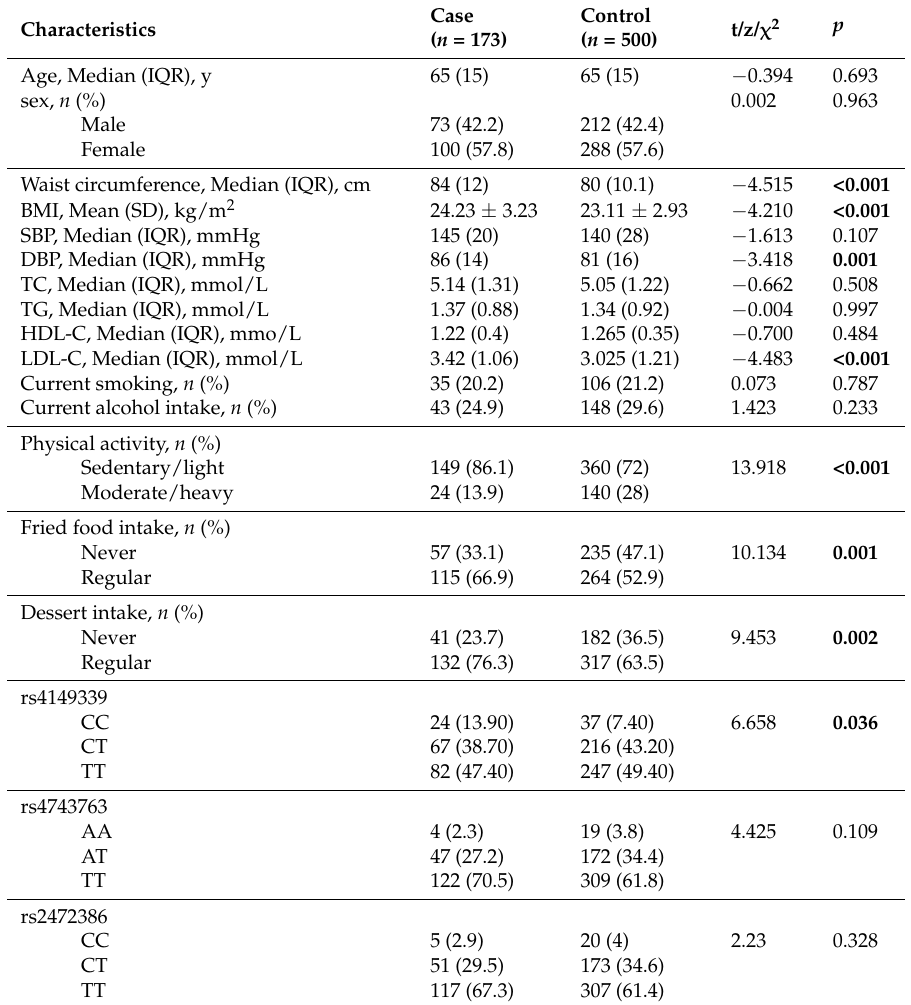
Table 1. General characteristics, Lifestyle factors and genotype distribution between case and control